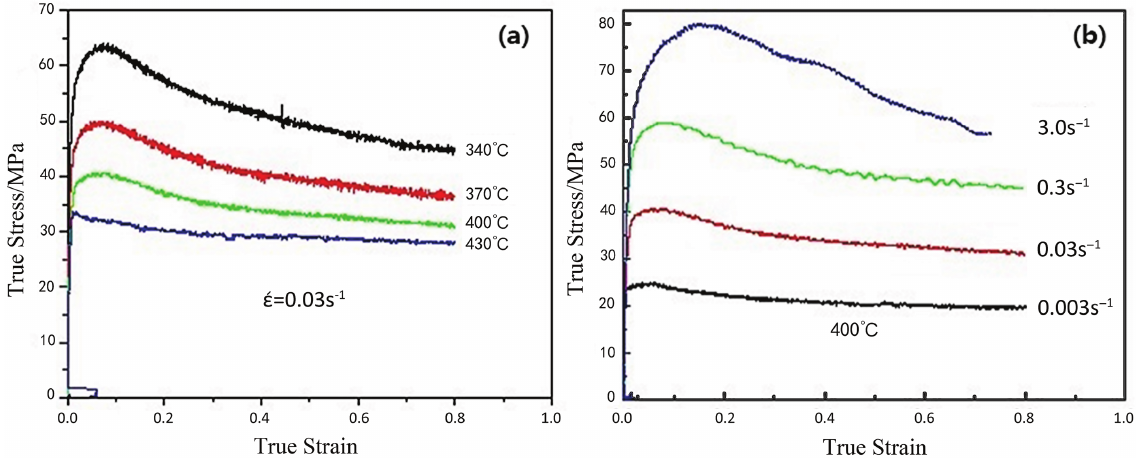
Figure 1: Flow stress and strain curves of AZ81E